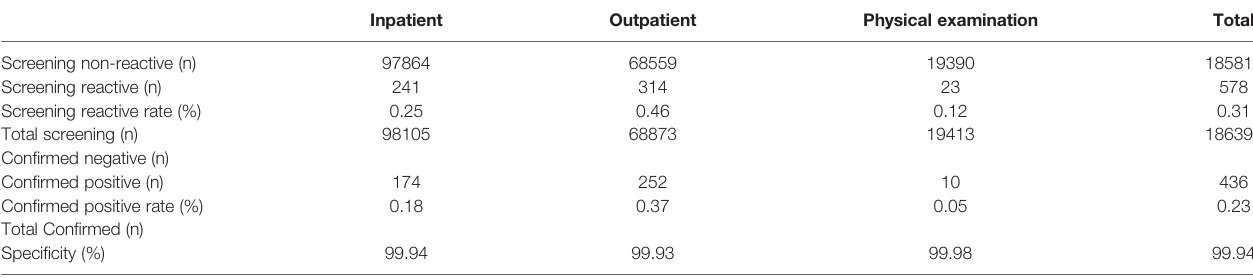
TABLE 1 | Detailed results for 186391 samples assayed and the overall speci fi city of each assay calculated by combining the data. Inpatient